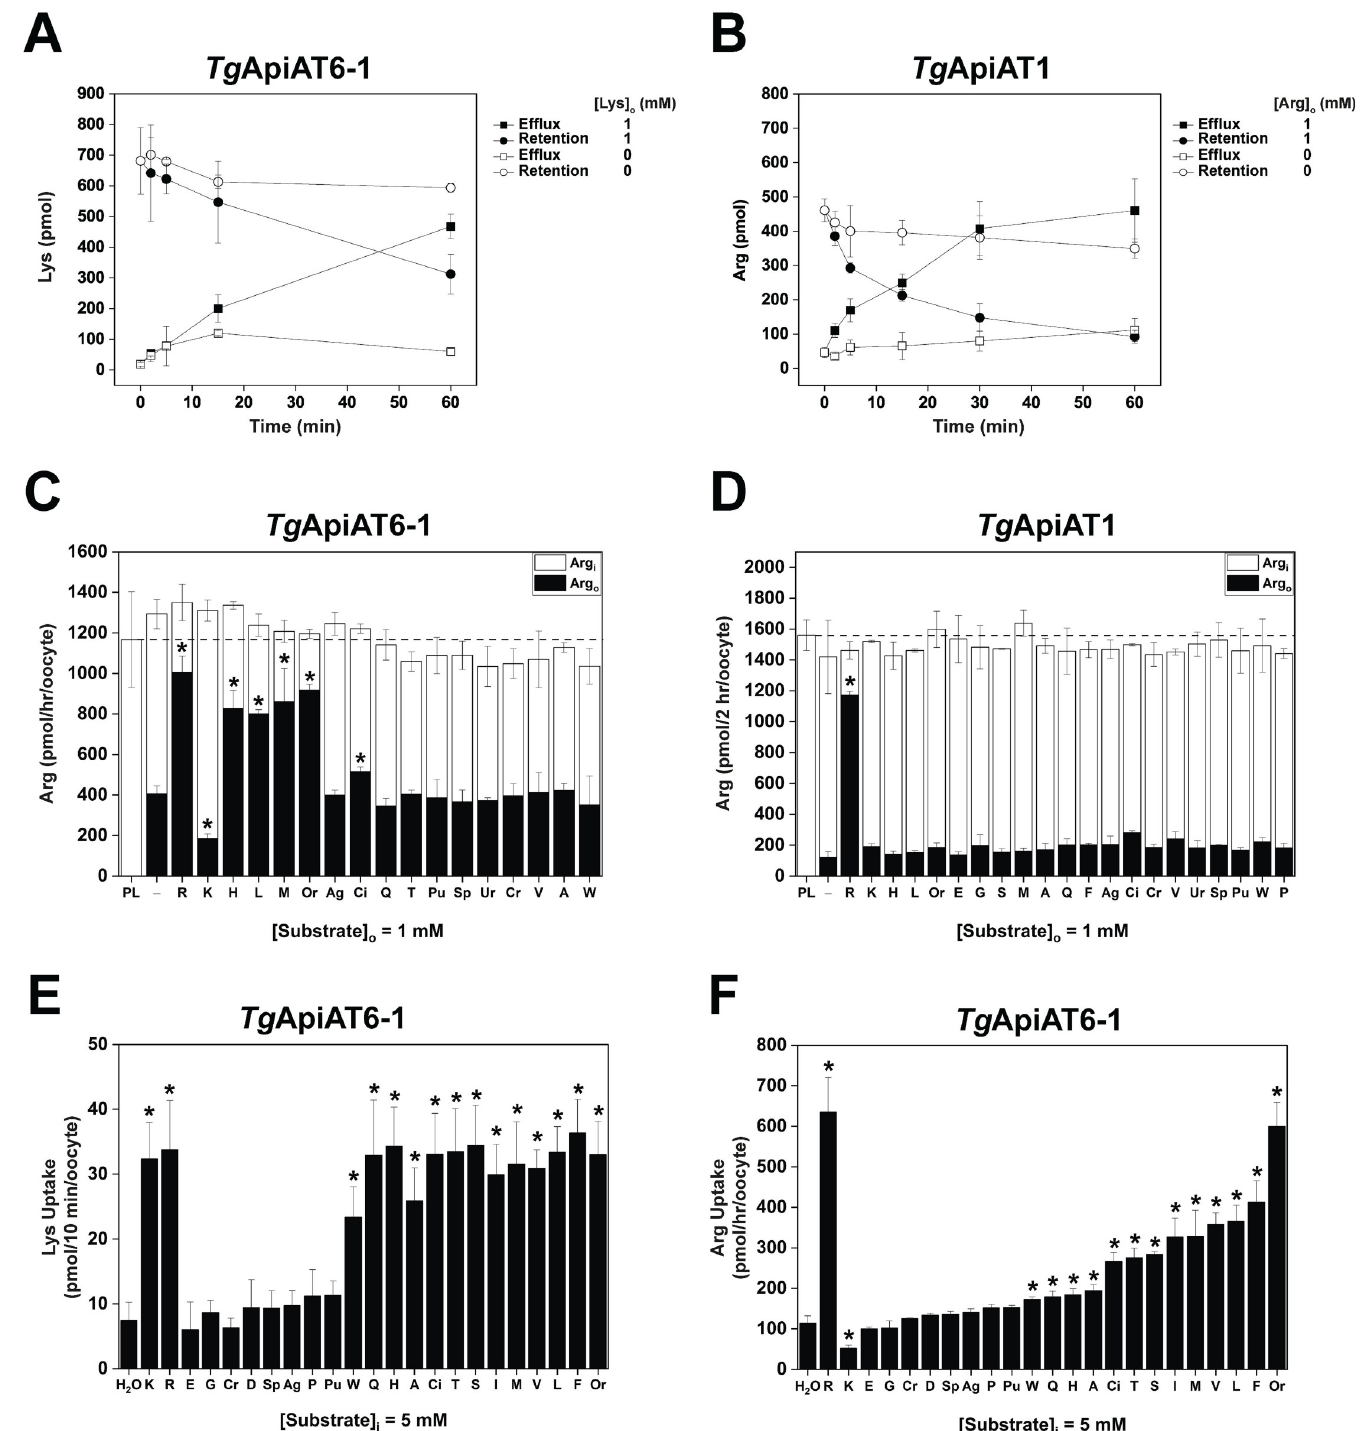
Fig 5. Trans -simulation of AA + transport in Tg ApiAT6-1- and Tg ApiAT1-expressing oocytes. A-B. Tg ApiAT6-1-injected (A) and Tg ApiAT1-injected (B) oocytes were pre-loaded with either 1 mM unlabelled Lys and 1.0 μ Ci/ml of [ 14 C]Lys ( Tg ApiAT6-1) or 1 mM unlabelled Arg and 1.0 μ Ci/ml of [ 14 C]Arg ( Tg ApiAT1) for 3–6 hr. The retention of substrates in Tg ApiAT6-1- or Tg ApiAT1-expressing oocytes were measured in the presence of 1 mM external substrate (closed symbols) or in the absence of an external substrate (open symbols). Data points represent the mean ± S.D. from 3 batches of 5 oocytes from one experiment, and are representative of 3 independent experiments. C-D . Arg efflux and retention in Tg ApiAT6-1 expressing (C) and Tg ApiAT1 expressing (D) oocytes in the presence of candidate trans - stimulating substrates. Oocytes were pre-loaded (PL) with Arg by first microinjecting Arg to a final concentration of ~5 mM, then incubated oocytes in a solution